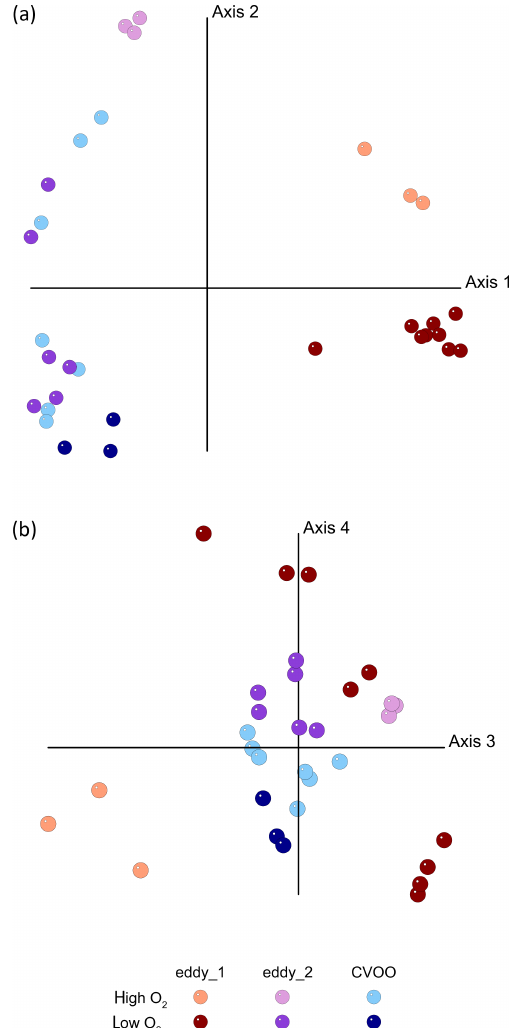
Figure 5. Redundancy analysis (RDA) of OTU distribution in sam- ples from the first eddy observation (eddy_1), from the second eddy observation (eddy_2) and from CVOO based on 16S rDNA se- quences. (a) First and second axis, (b) third and fourth axis of the RDA model, illustrating the interaction effect of factor “Realm” and O 2 concentration. For plotting, the continuous variable “O 2 ” was converted into a factor with two levels “high O 2 ” (>90µM) and “low O 2 ” ( ≤ 90µM).